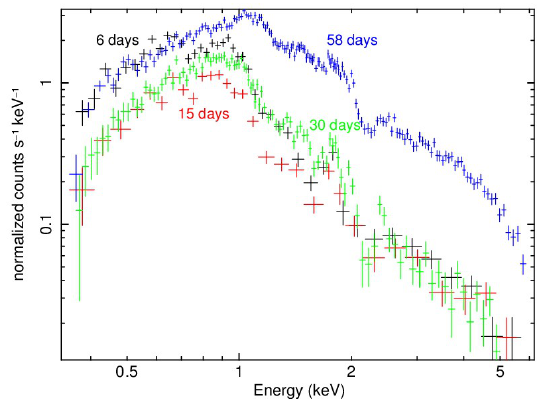
Figure 1: Chandra X-ray outburst spectra of WZ Sge in 0.3-10.0 keV range obtained with ACIS-S (CC- mode). The observation days after the outburst are labeled on each